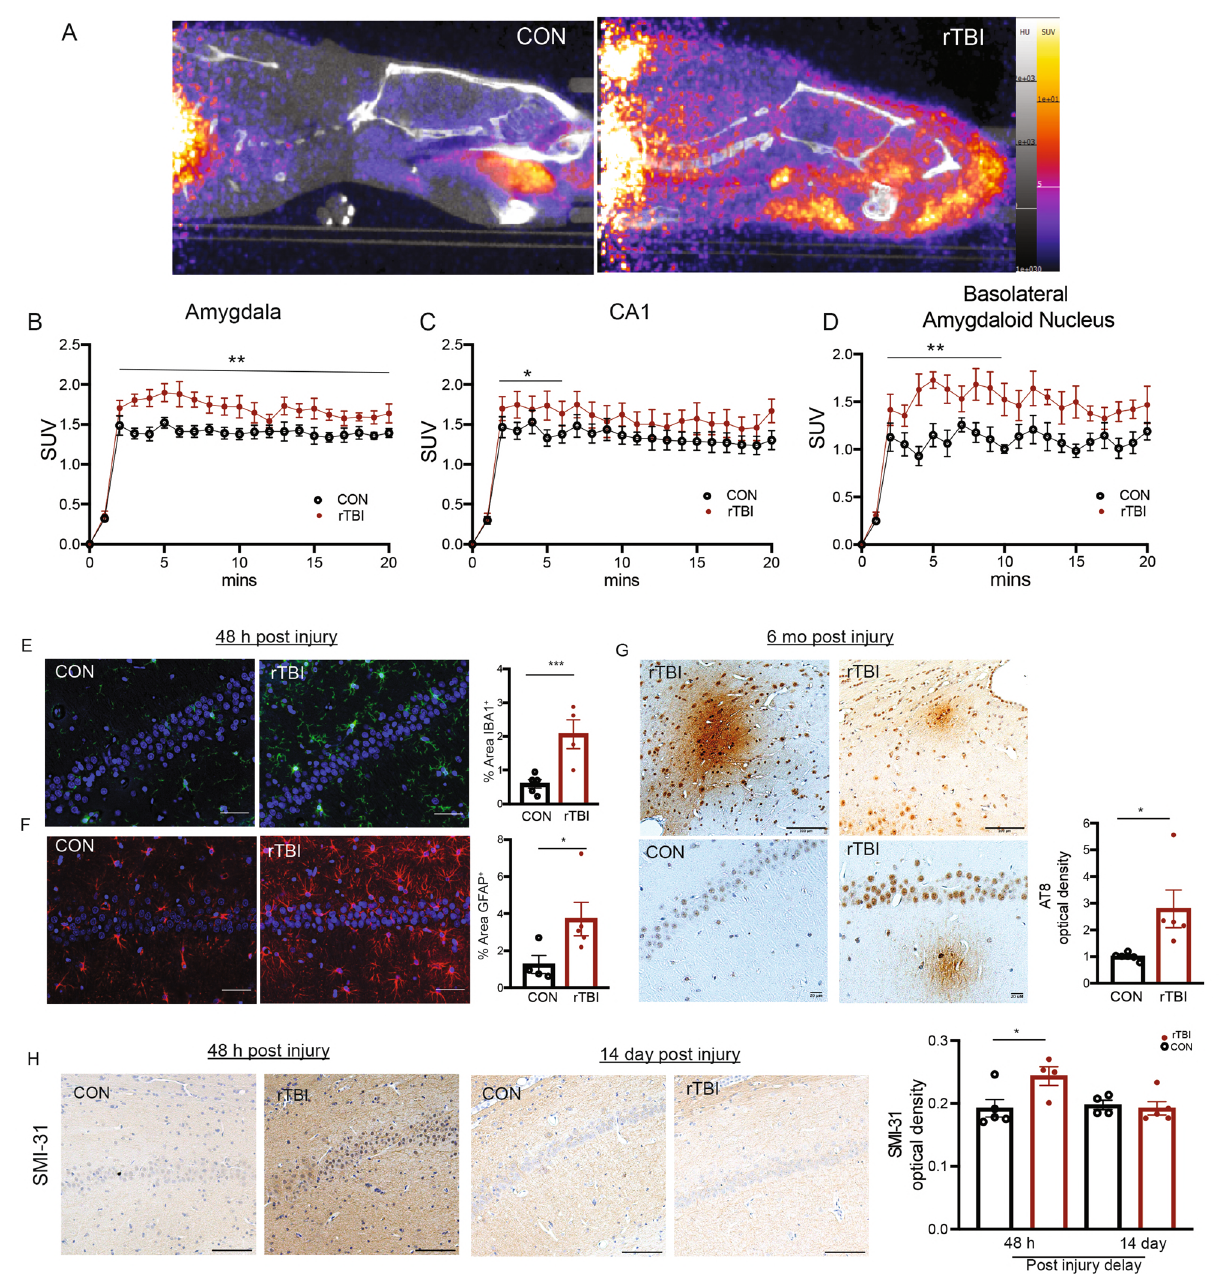
Figure 2. Neuropathological effects of rTBI. ( A ) Representative PET/CT images for TSPO uptake in control (left) and rTBI (right) rats (n = 6 per group). ( B ) Quantitative Standard uptake values (SUV) for TSPO radioligand in amygdala (Time: F(20,200) = 110.6, p < 0.0001; Treatment: (1, 10) = 7.771, p = 0.0192; Interaction: (20, 200) = 2.321, p = 0.0017) two-way-RM ANOVA. ( C ) CA1 (Time: F(5,50) = 216.4, p < 0.0001; Treatment: F(1,10) = 1.711, p = 0.2202; Interaction: F(5,50) = 2.614, p = 0.0355) two-way-RM ANOVA. ( D ) Basolateral amygdaloid nucleus (Time: F(10,100) = 4 9.67, p < 0.0001; Treatment: F(1,10) = 13.97, p = 0.0039; Interaction: F(10,100) = 2.605, p = 0.0075). ( E ) Histological staining and quantitation for IBA1 + microglia within CA1, p = 0.0083 Student’s t-test . (n = 4–5 per group) Scale bars = 50 µm. ( F ) Histological staining and quantitation for GFAP + astrocytes within CA1, p = 0.0317 Mann Whitney test ( p = 0.0300, Shapiro–Wilk) (n = 4–5 per group) Scale bars = 50 µm. ( G ) Histological staining for AT8 + (Top, left) and condensed staining around vessels (Top, right) Scale bars = 100 µm. Histological staining and quantification of AT8 density in CA1 at 6 months post injury (bottom) p = 0.0210 Student’s t -test (n = 5 per group) Scale bars = 20 µm. ( H ) Histological staining for SMI-31 at 48 h and 14 days post injury. (n = 4–5 per group) (48 h Con-TBI, p = 0.0409 Student’s t -test). All data are means ± SEM, * p < 0.05, ** < 0.01, ** < 0.01, **** <